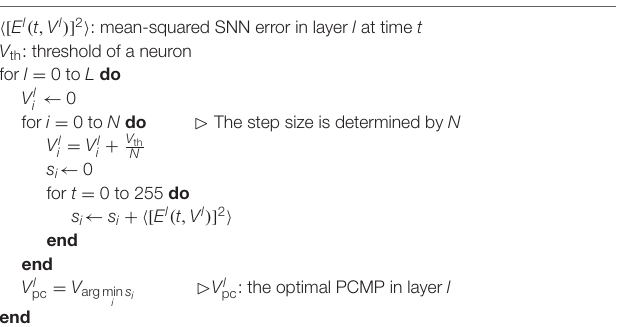
Algorithm 1: Layer-Wise